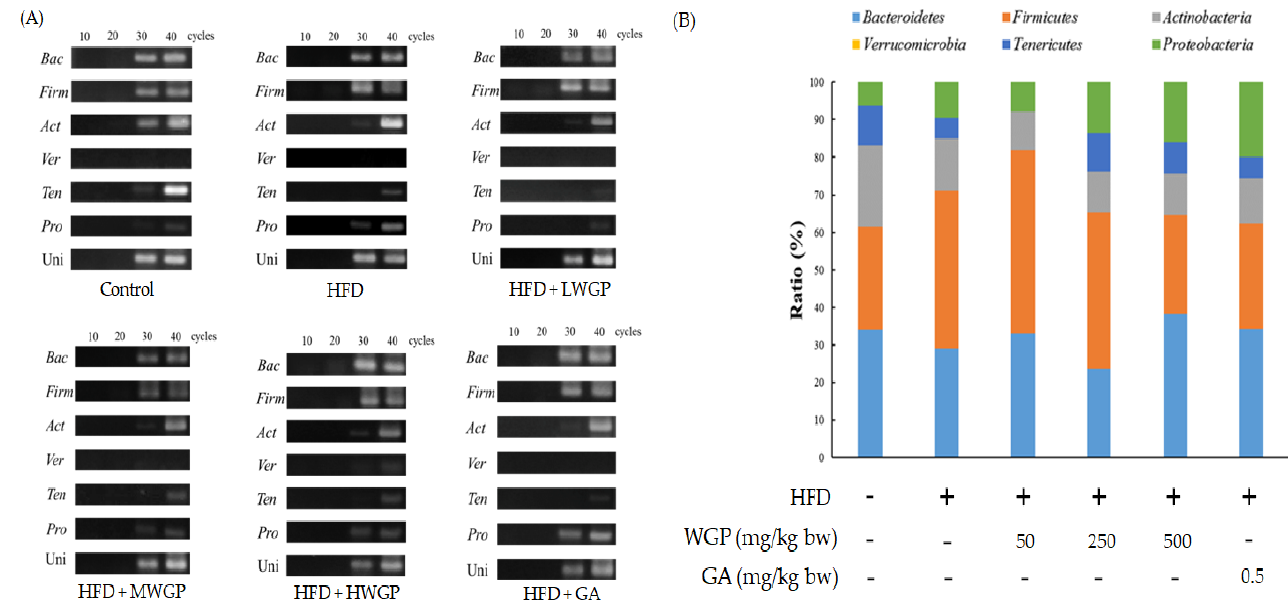
Figure 5. Effects of WGP on microbial composition in the feces of the HFD − induced C57BL/6J mice: ( A ) PCR measurements and ( B ) percentages. Bac , Bacteroidetes ; Firm , Firmicutes ; Act , Actinobacteria ; Ver , Verrucomicrobia ; Ten , Tenericutes ; Pro , Proteobacteria ; Uni, universal.